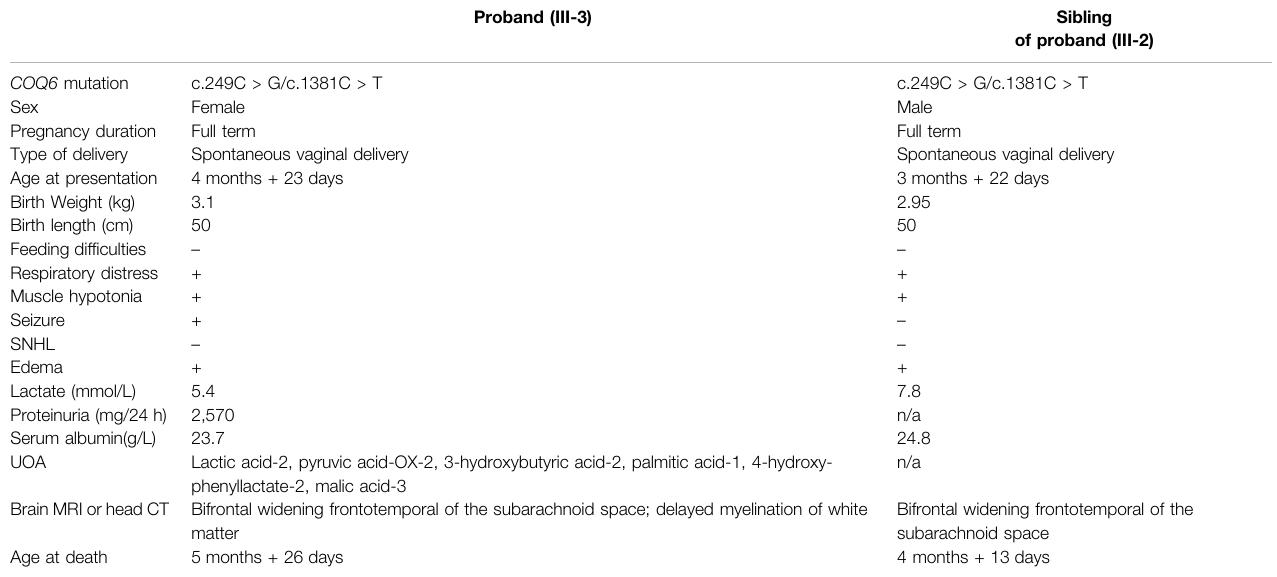
TABLE 1 | Clinical characteristics and molecular fi ndings in subjects with COQ6